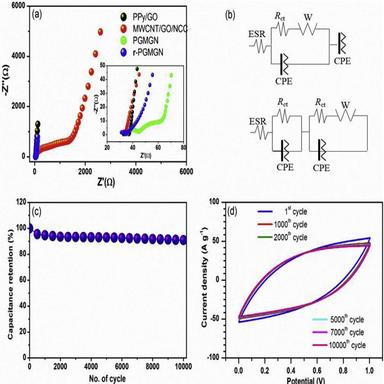
(A) Nyquist plots (bottom right shows the magnification of the high-frequency region), (b) the electrical equivalent circuit of symmetrical supercapacitor devices for PPy/GO, PPy/rGO, MWCNT/GO/NCC, MWCNT/rGO/NCC, PGMGN and r-PGMGN recorded in the frequency range of 10 mHz–100 kHz, (c) capacitance retention and (d) CVs of r-PGMGN as a function of cycle number at 200 mV s−1 for 10,000 cycles.